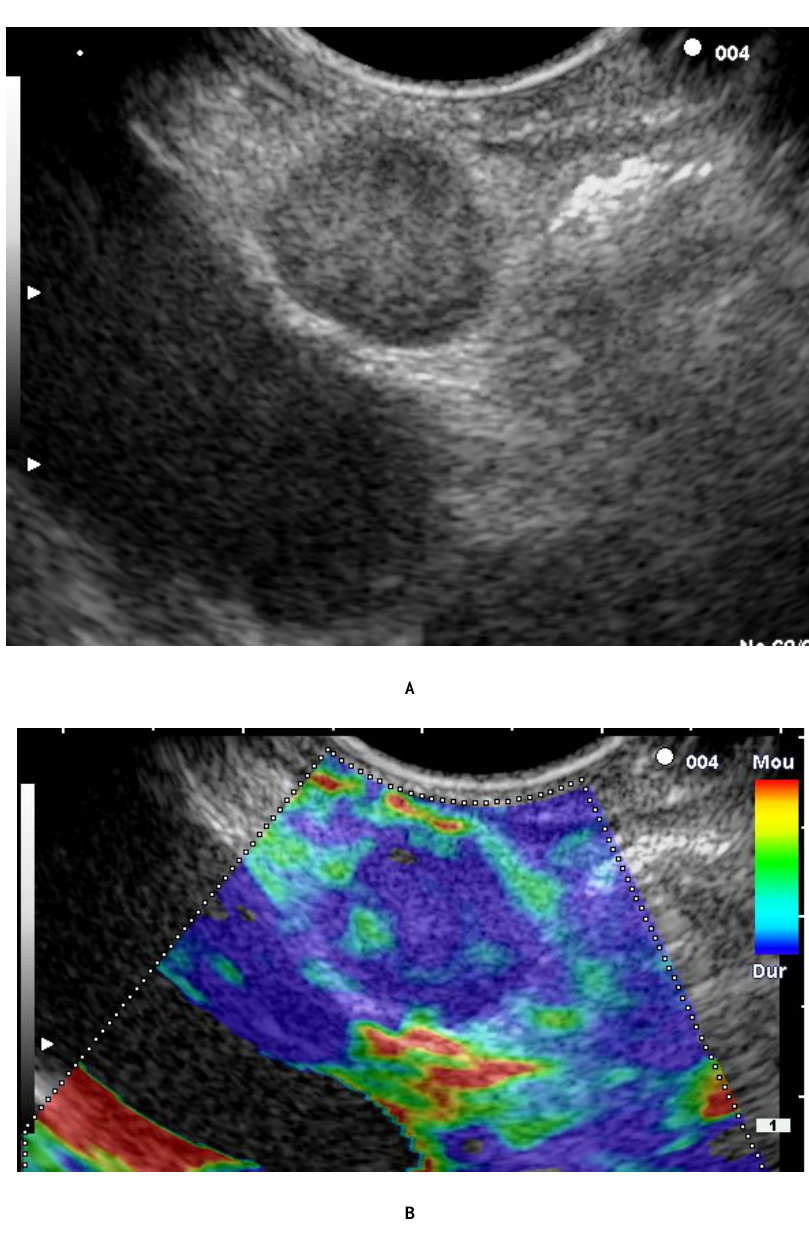
FIGURE 16 . (A) Pericaval LN; (B) elastography: malignant LN: Score